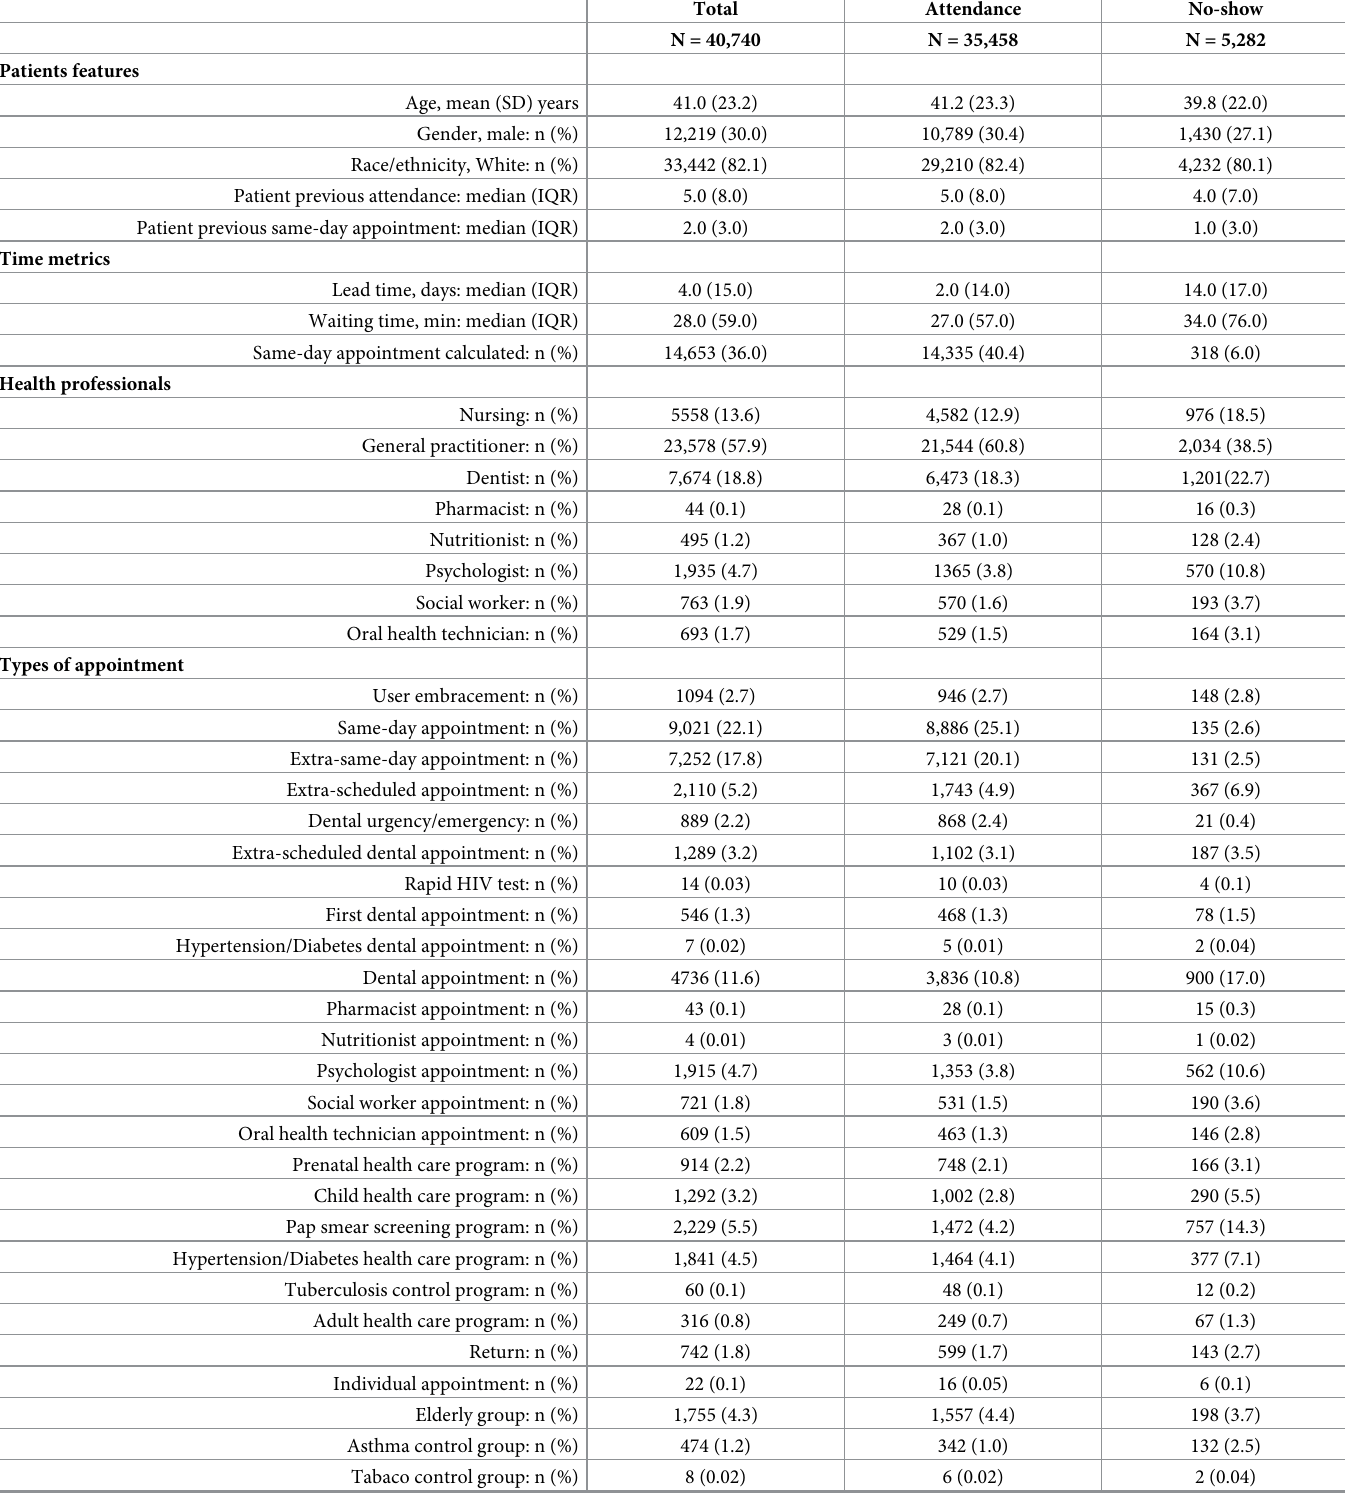
Table 1. Descriptive analysis of the variables by the